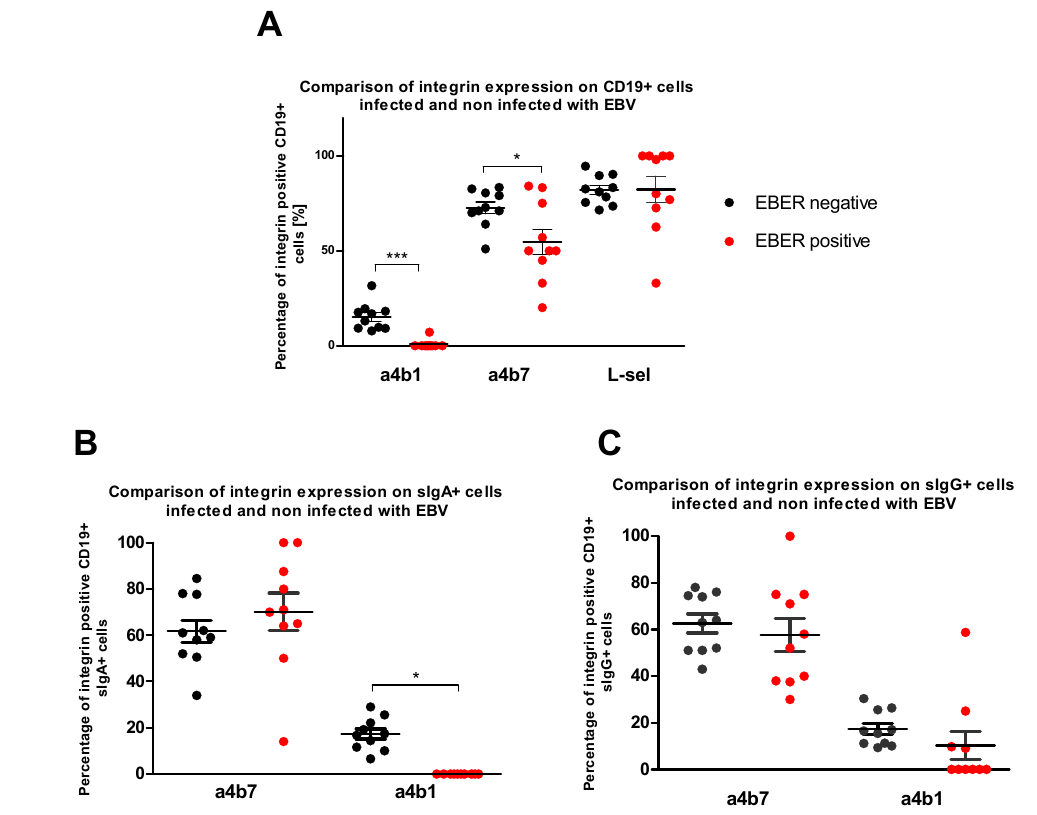
Fig. 4. Integrin molecules expression in total B-, sIgA + - and sIgG + - cells relative to EBV infection.